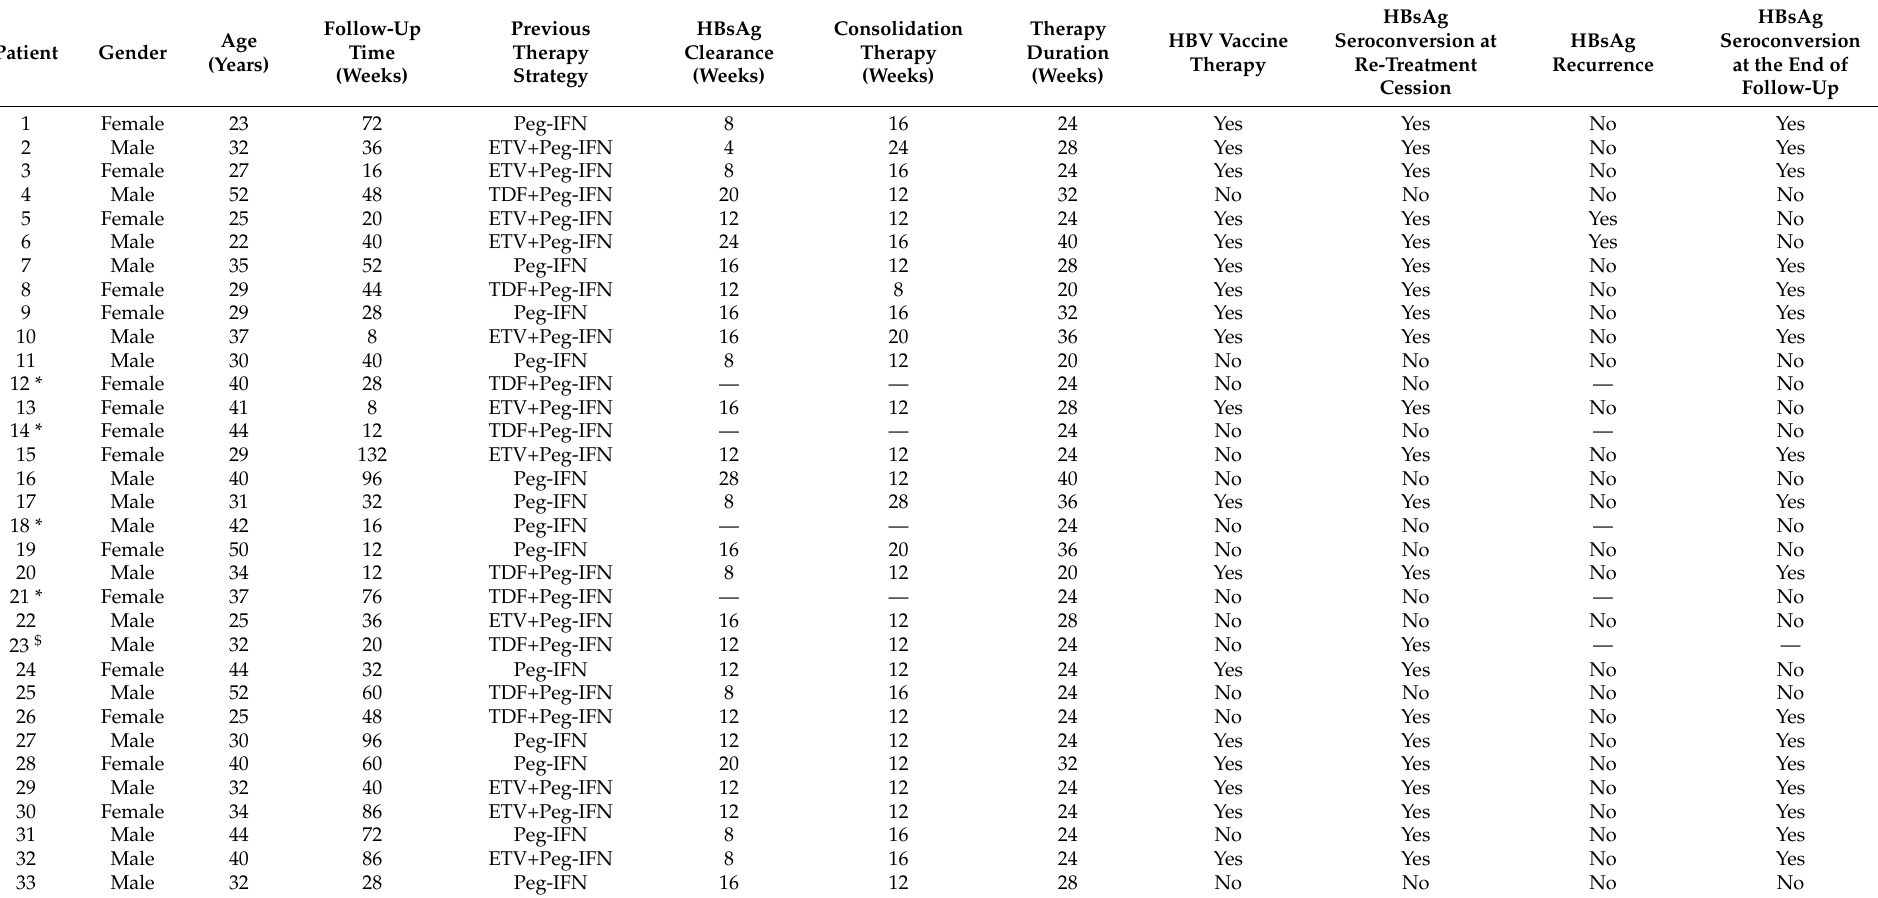
Table 2. Detailed therapeutic and follow-up information for the 33 patients enrolled in this